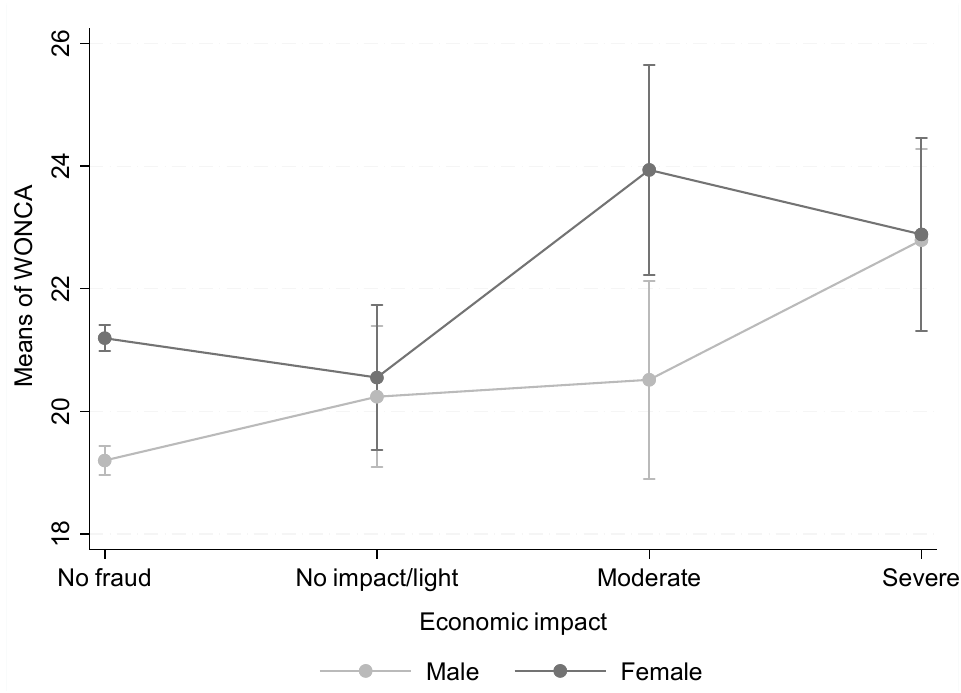
Figure 3. COOP / WONCA scores by economic impact on family finances Higher COOP / WONCA scores mean lower health-related quality of life. The p -value for interaction of sex and economic impact on family finances = 0.042.